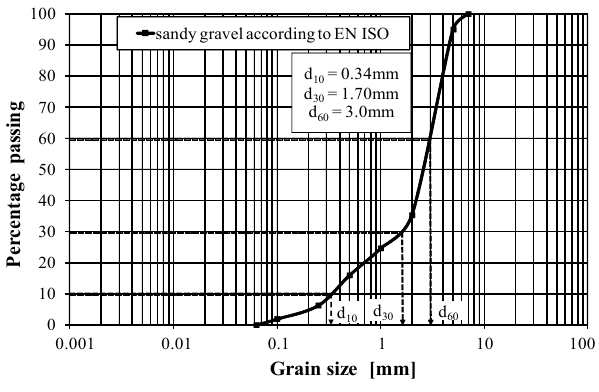
Fig. 2. Grain-size distribution of the material tested, where d 10 is the grain diameter of 10% passing, d 30 is the grain diameter of 30% passing and d 60 is the grain diameter of 60% passing